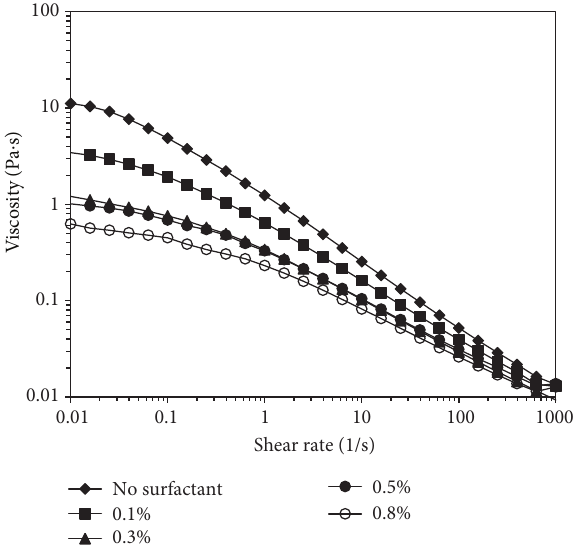
Figure1:Effectofsurfactantconcentrationonsteadyshearviscosity of copolymer at different shear rates in deionized water at 50 ∘ C.